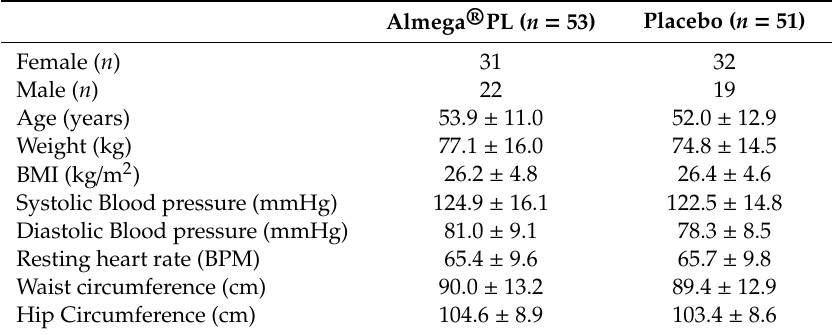
Table 1. Baseline participant details.